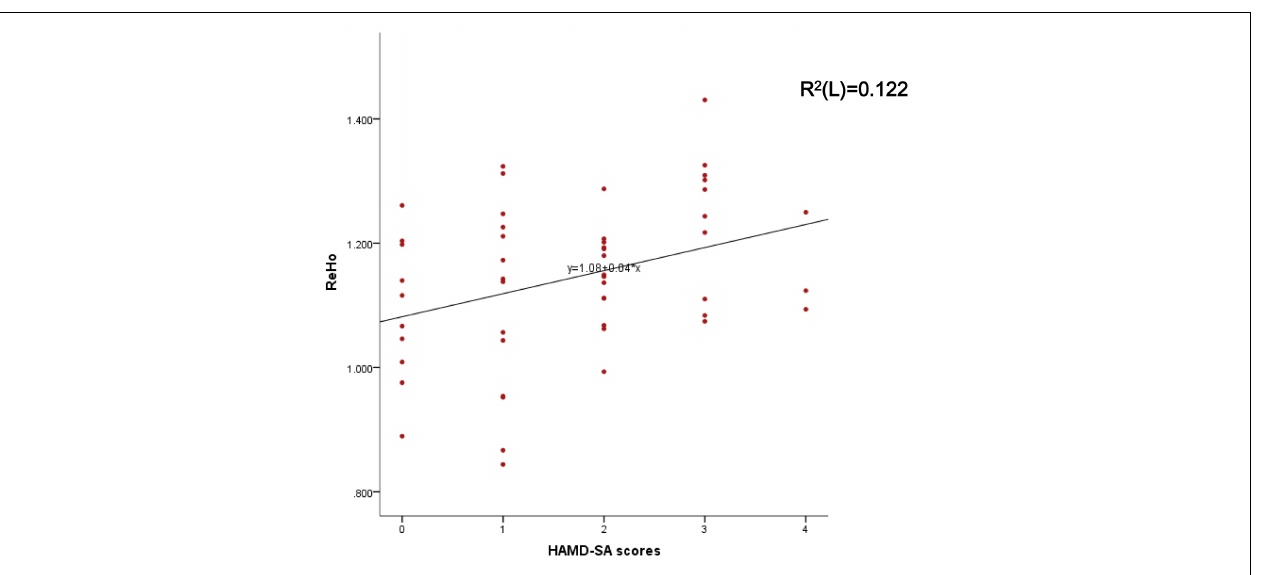
FIGURE 2 | Represents the correlation between the mean ReHo of the right Cingulate Gyrus and HAMD-SA